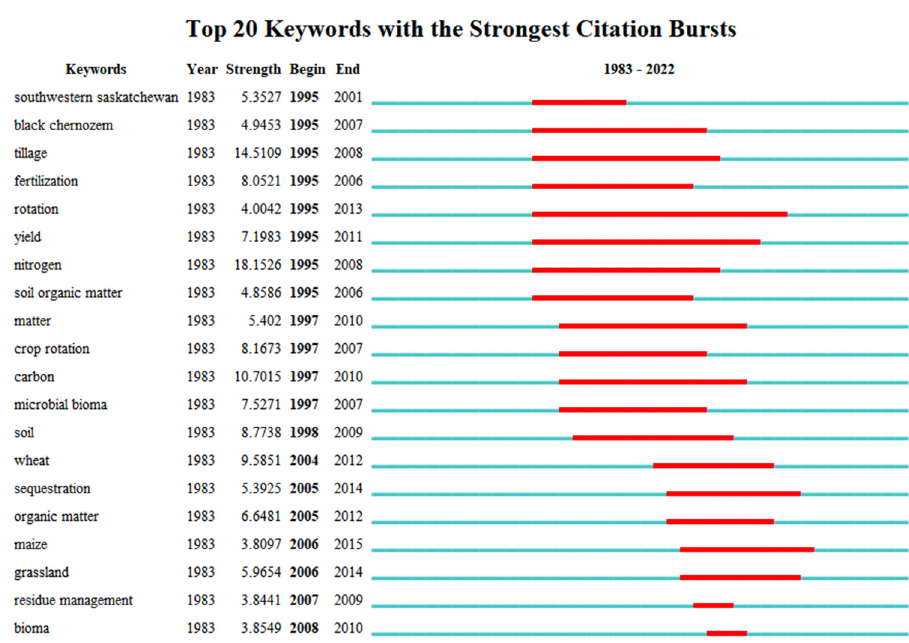
Figure 7. Time zone map of the evolutionary path of the BSC study. The label next to a node indicates the keyword represented by that node. The size of the node is proportional to the frequency of the keyword. The purple halo at the periphery of the node indicates that the node has high mediated centrality (mediated centrality >0.1). The red part in the node means that the node has a high emergent value. The left-to-right ordering of the nodes indicates the year of publication of the literature from far to near. The connecting lines between nodes represent the strength of association between keywords.